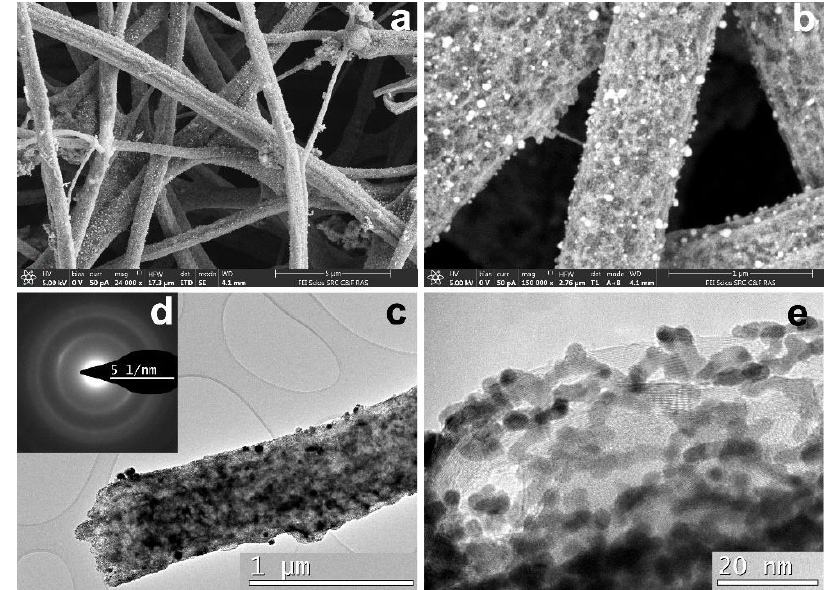
Figure 14. CNF/Co/Sm structure for Pt/3: ( a ) and ( b ) SEM images; ( c ) and ( d ) a fragment of CNF and corresponding SAED pattern; ( e ) Pt morphology.